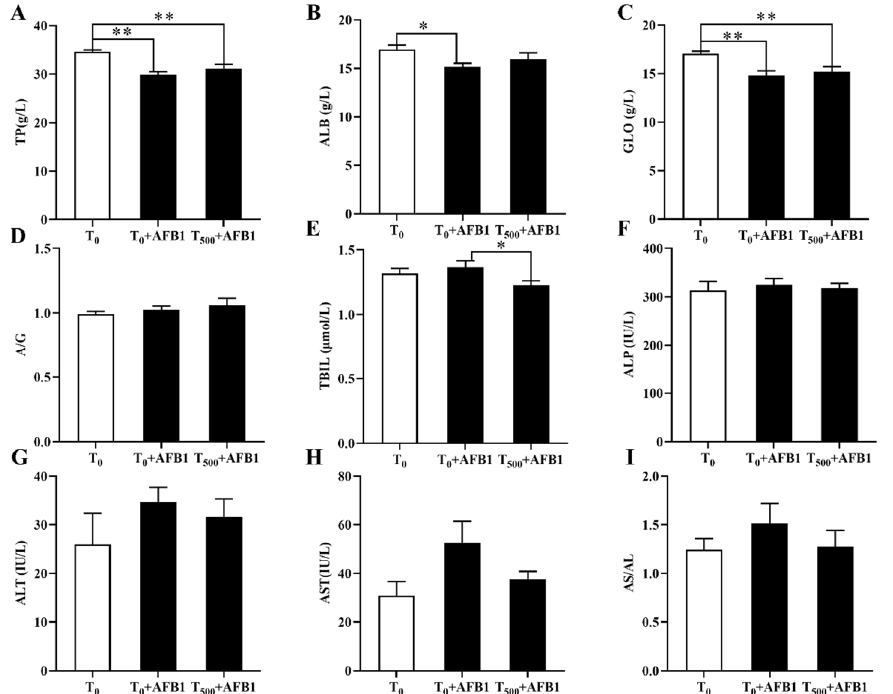
Figure 1. The plasma biochemical levels of ducks exposed to AFB1 at 12 h. ( A ) The TP content in the plasma of ducks; ( B ) The ALB content in the plasma of ducks; ( C ) The GLO content in the plasma of ducks; ( D ) The rate of ALB/GLO; ( E ) The TBIL activity in the plasma of ducks; ( F ) The ALP activity in the plasma of ducks; ( G ) The ALT activity in the plasma of ducks; ( H ) The AST activity in the plasma of ducks; ( I ) The rate of AST/ALT. Values mean the mean ± SEM (standard error (SE) of means.), * means p < 0.05, ** means p < 0.01.